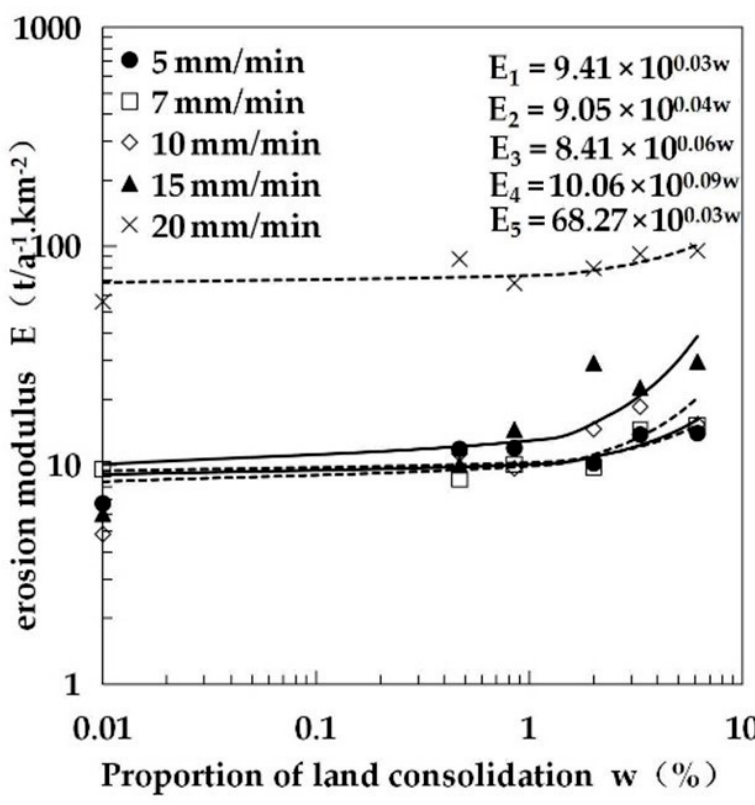
Figure 28. Changes in erosion modulus with land consolidation proportion under a rainfall capacity of 150 mm.